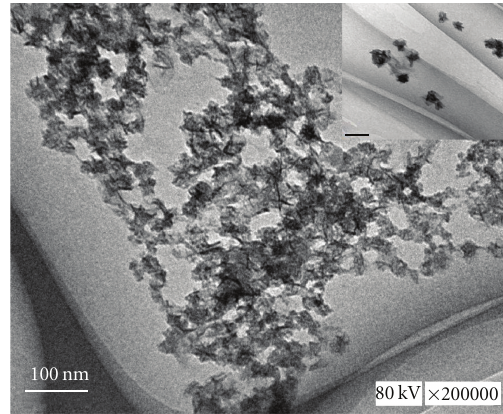
Figure 3: TEM micrographs of MnO 2 self-assembled thin films as deposited on Ni/PET supporting substrate. Inset showed well- dispersed nanoclusters and individual